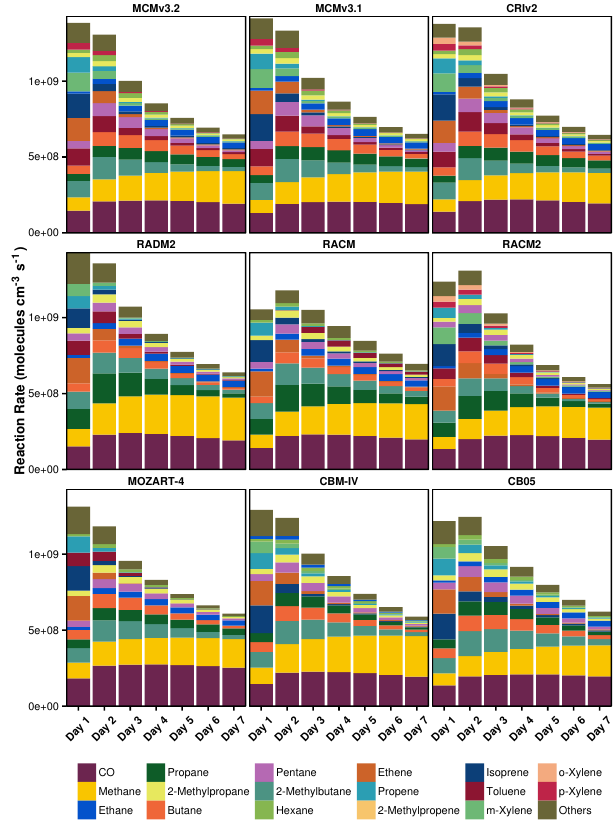
Figure 2. Day-time O x production budgets in each mechanism al- located to individual